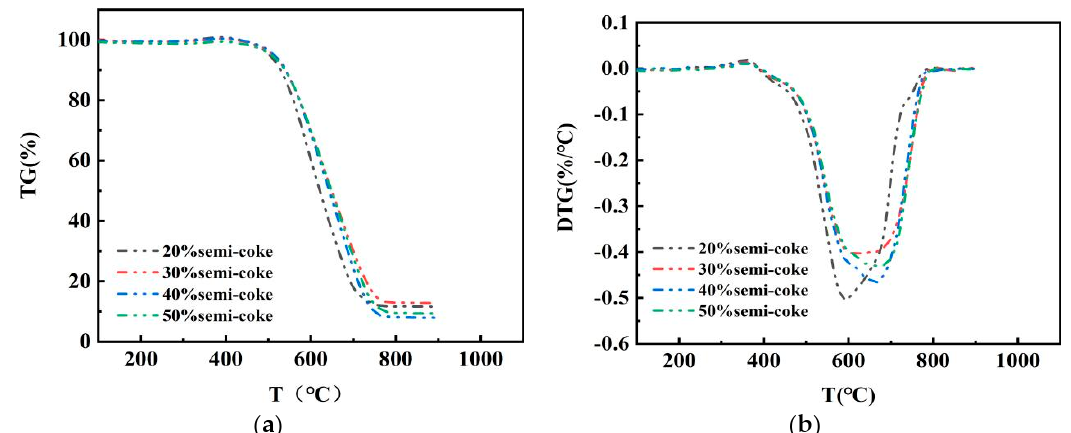
Figure 2. TG–DTG for combustion of semicoke mixed with bituminous coal with different addition ratios. ( a ) TG and ( b ) DTG curves for different semicoke ratios in pulverized coal blends. Table 2. Combustion parameters for anthracite and bituminous coal after uniform mixing at 1:1. Samples